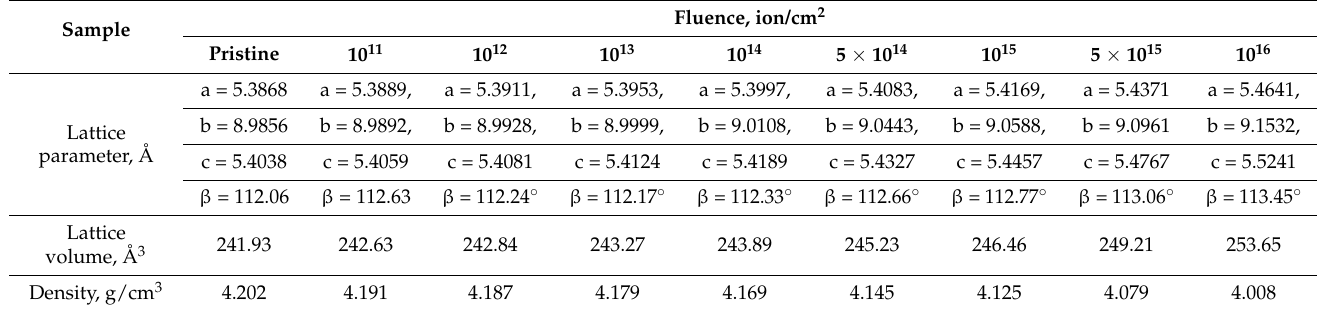
Figure 4. Angular dependences of changes in the FWHM values of the studied ceramics. Based on the data obtained, the crystal lattice parameters were calculated, which reflect its change as a result of external influences associated with the crystal structure parameters determined for the irradiated samples depending on the irradiation fluence. The parameters were refined using the Nelson–Taylor equations. Table 1. Data on changes in the crystal lattice parameters depending on the radiation fluence.